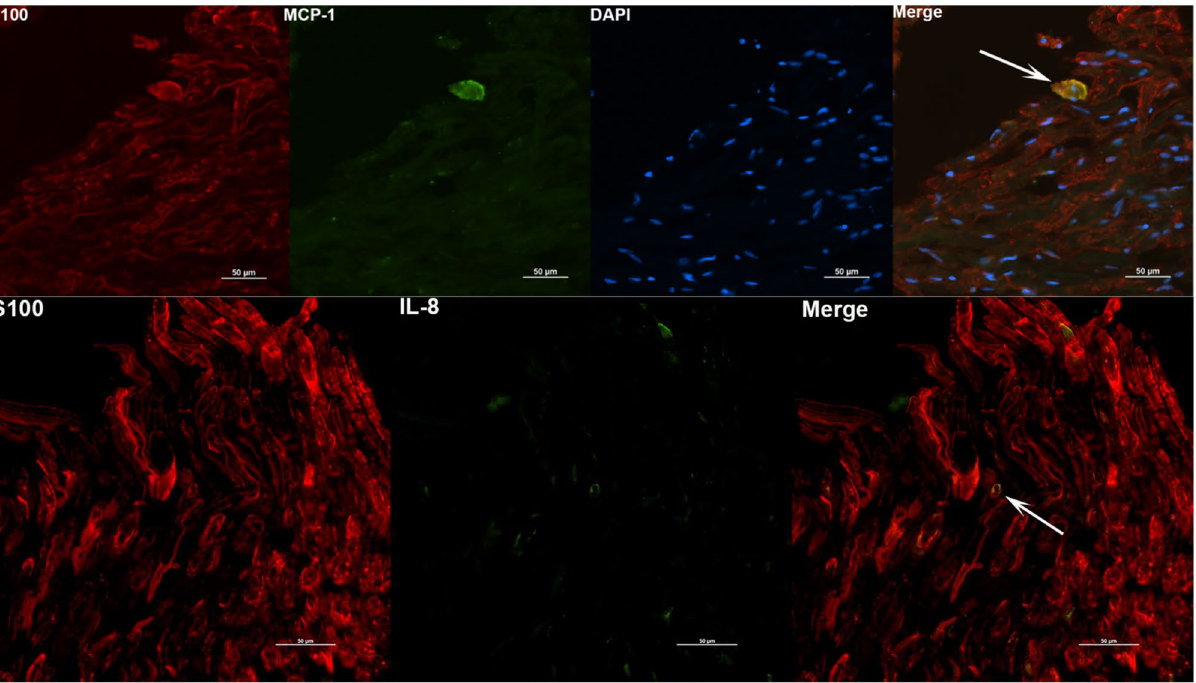
Figure 4. Identity of DRG cells responding to non-viable B. burgdorferi . DRG tissues were stained for immune mediators (green) and S100 (red). Positive staining for MCP-1 and IL-8 was seen in S100 positive cells, shown as yellow colocalizations (White arrows). Top panel is from Animal 3 tissue while the bottom panel is from Animal 4